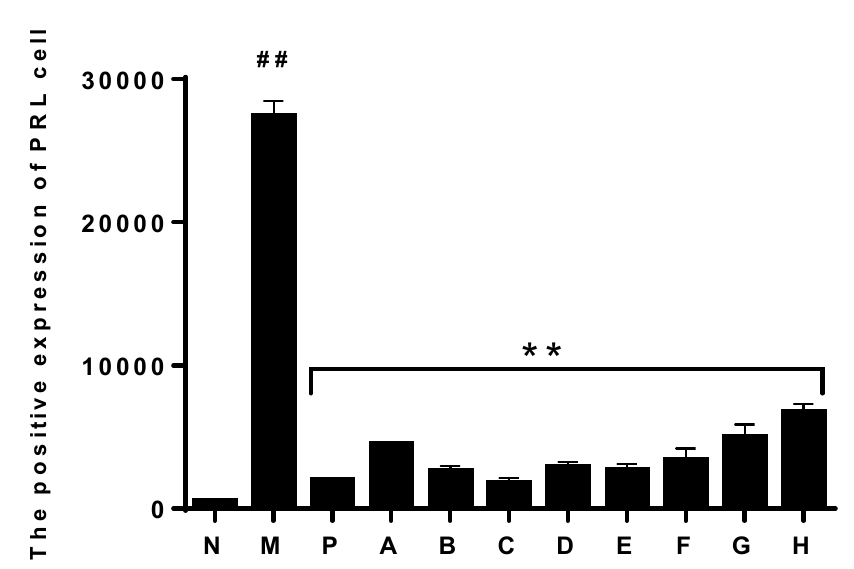
FIGURE 5 – The effects of decoction of different buds of malt on the positive expression of PRL cells in the pituitary gland of HPRL rat model. Rat model of HPRL was produced by repeated injection with 75 mg/kg MCP for 10 days, followed by treatment with or without 9.46 g/kg decoction of different buds of malt (A to H) or 0.4 mg/kg BMT (P) for 30 days. 0.9% salt solution treated rats were served as model group (M). Normal group were non-modeling and treated (N). At the completion of experimental treatment, tissues of pituitary gland of rats in each group were collected respectively. The positive expression of PRL cells were determined by immunohistochemistry. Data are expressed as mean ± SEM (n = 4). ## P < 0.01 vs. normal group, ** P < 0.01 vs. model group.